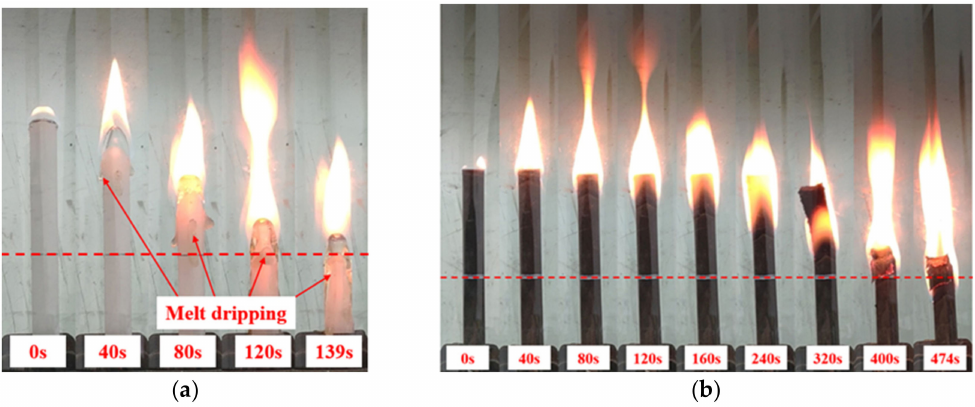
Figure 7. The combustion process of samples at an oxygen concentration of 20%: ( a ) PP; and ( b )